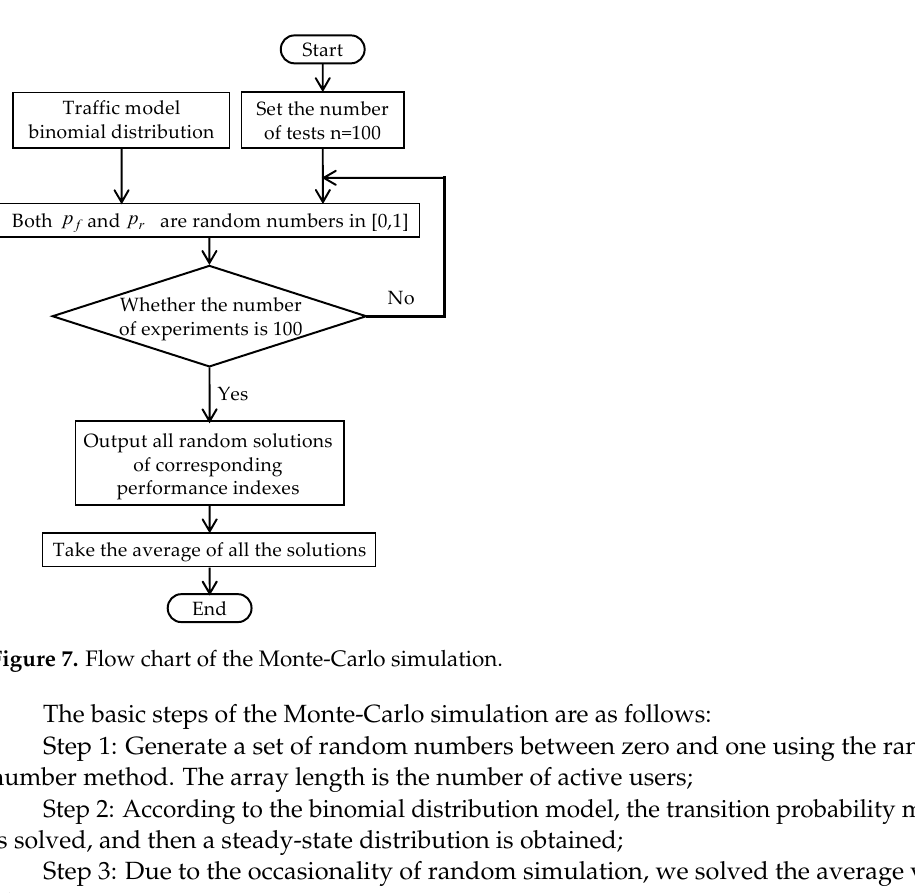
Figure 9. Throughput vs. first transmission probability (Ana. vs. Sim.). Figure 10 demonstrates the number of backlogged users as a function of the first transmission probability based on Equation (13). It can be seen that the minimum number of backlogged users is obtained at 01.0  f p